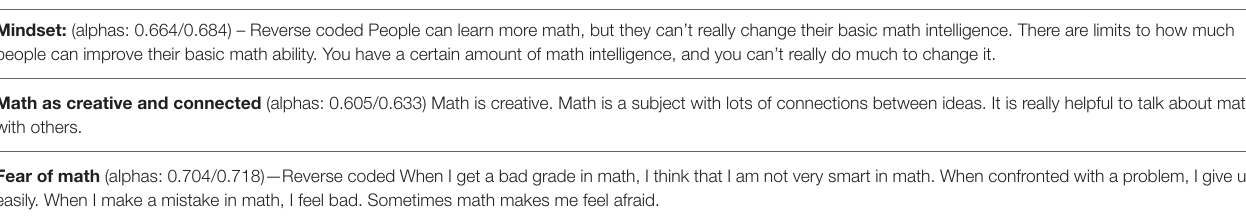
TABLE 9 | Measures of student mindset survey (cluster items with alpha levels) 1 = Strongly disagree, 2 = Disagree, 3 = Somewhat disagree, 4 = Somewhat agree, 5 = Agree, 6 = Strongly agree. Mindset: (alphas: 0.664/0.684) – Reverse coded People can learn more math, but they can’t really change their basic math intelligence. There are limits to how much people can improve their basic math ability. You have a certain amount of math intelligence, and you can’t really do much to change it. Math as creative and connected (alphas: 0.605/0.633) Math is creative. Math is a subject with lots of connections between ideas. It is really helpful to talk about math with